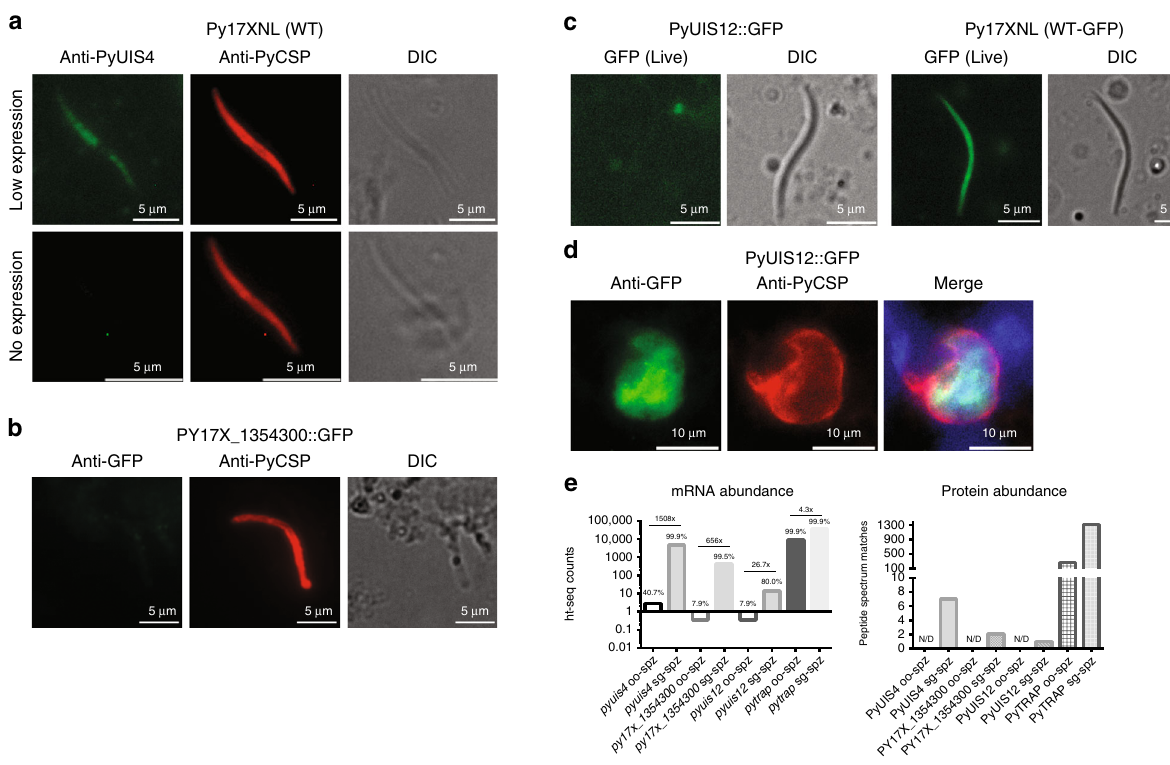
Fig. 4 Validation of translationally repressed transcripts in P. yoelii . The presence and relative abundance of proteins encoded by translationally repressed mRNAs was assessed by fl uorescence microscopy. a PyUIS4 expression is largely absent in the population of wild-type sporozoites taken shortly after salivary gland invasion. Very few sporozoites have detectable PyUIS4 protein, which is weak and diffuse. b An uncharacterized protein, PY17X_1354300, was modi fi ed to encode a C-terminal GFP tag, and protein expression was monitored by IFA. In agreement with the total proteomic data, no protein was detectable. c Transgenic parasites expressing unfused GFP (WT-GFP control) or GFP fused to UIS12 were assessed by live fl uorescence for evidence of protein expression. No PyUIS12::GFP could be detected above background in sporozoites. d However, robust expression of PyUIS12::GFP is detected by IFA post-transmission in 24 h liver stage parasites. Scale bars are 5 microns (panels a – c ) or 10 microns (panel d ). e The abundance of mRNA (left) and protein (right) for PyUIS4, PY17X_1354300, and PyUIS12 are provided in comparison to PyTRAP. The percentile of mRNA abundances (based upon ht-seq counts) compared to all other transcripts is provided, with the fold change between oocyst sporozoites and salivary gland sporozoites noted above paired bars. The number of total, unambiguous peptide spectrum matches is provided. N/D: not